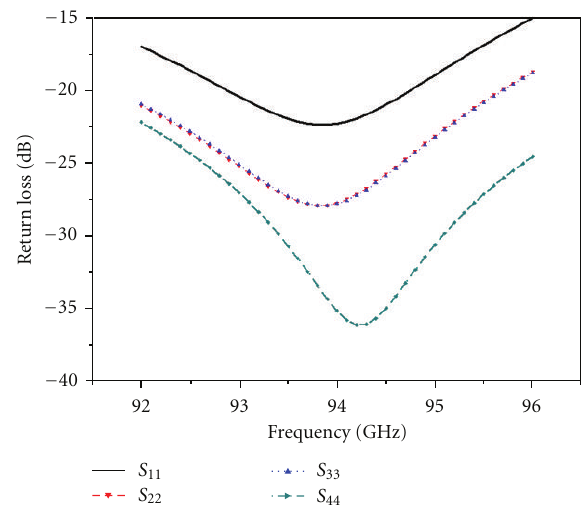
Figure 5: Fully compensated E-FMT refection coe ffi cient of all ports.